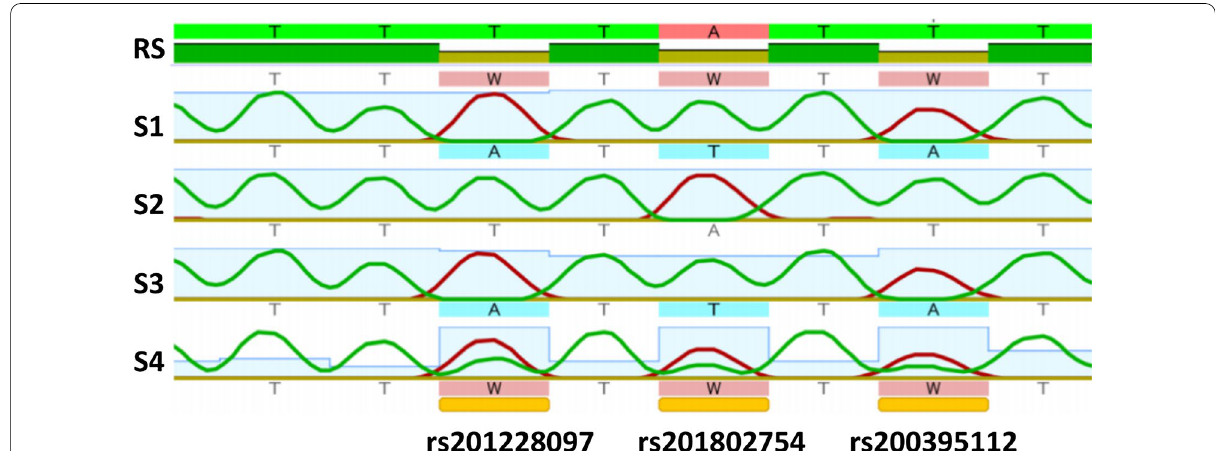
Fig. 1 DNA sequence chromatogram of three TLR10 gene SNPs (rs201228097, rs201802754 and rs200395112) showing genotypes of four samples (S1, S2, S3 and S4). Besides, reference sequence (RS) is also given. The chromatogram was generated by Geneious software analysis (version